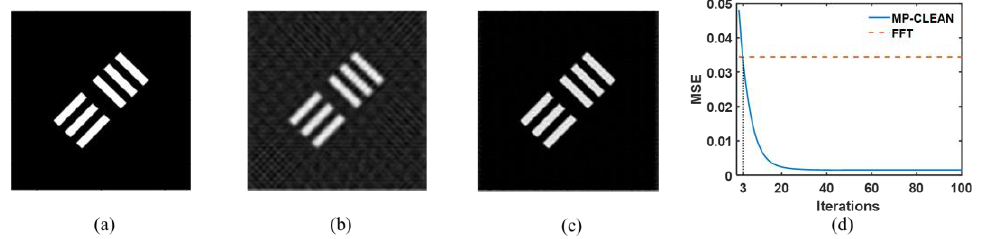
Figure 5. ( a ) Original image for MP-CLEAN simulation. ( b ) Imaging result without MP-CLEAN. ( c ) Imaging result with MP-CLEAN. ( d ) Rendering of MP-CLEAN algorithm with iterations.